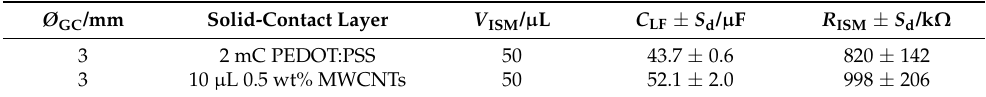
Table 1. The low-frequency capacitance ( C LF ) and bulk resistance ( R ISM ) values calculated from the EIS spectra of K + -SCISEs. S d = standard deviation (n = 3).